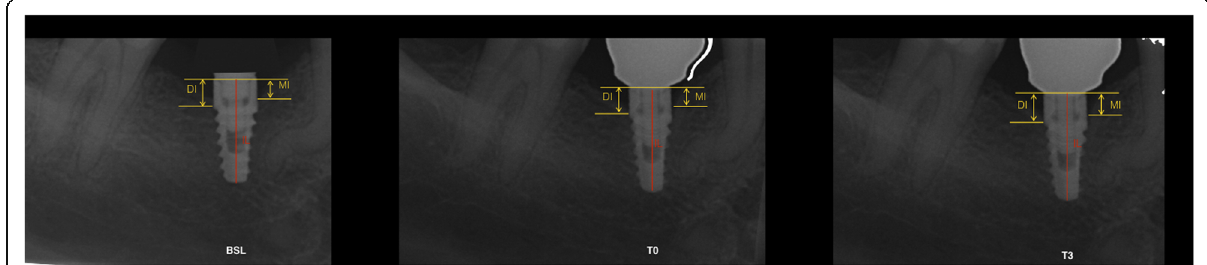
Fig. 1 Example of the location of a non-submerged implant, bone, and adjacent tooth